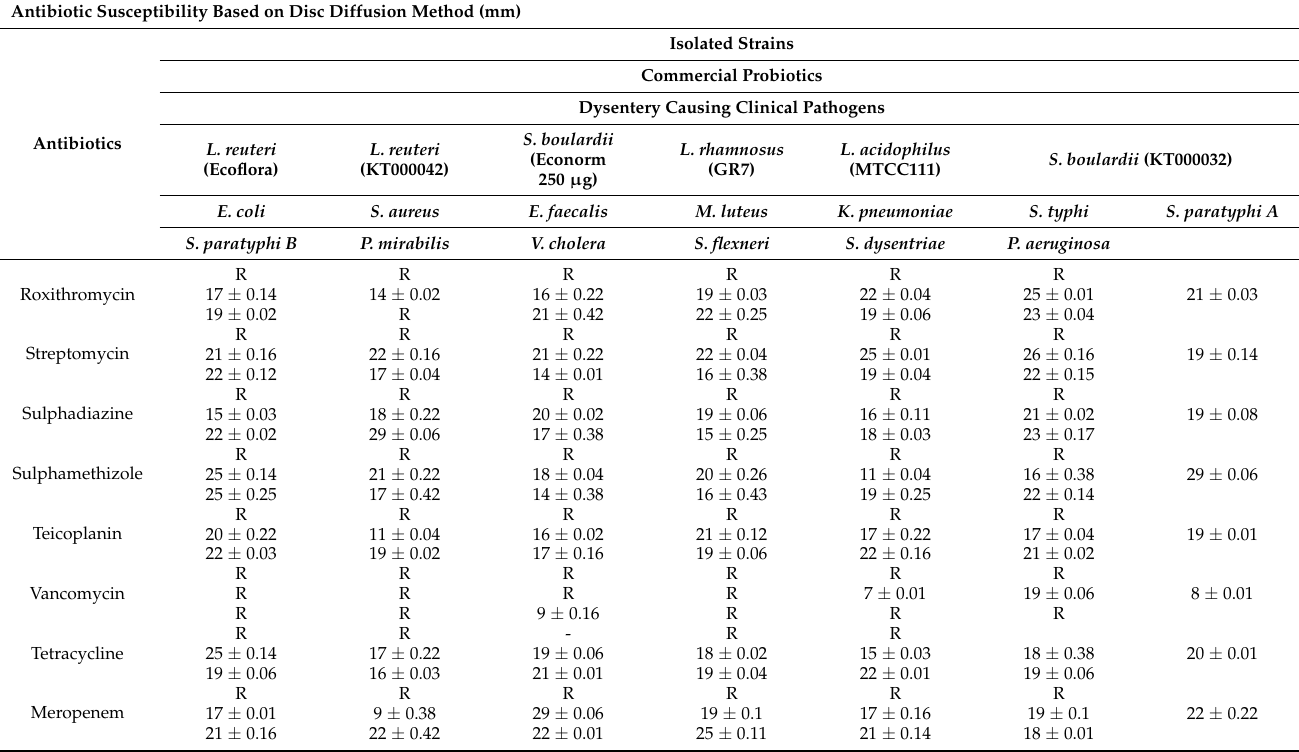
Table 10. Heat stability of S. boulardii strains towards heat treatment at 95 °C and 121 °C with different periods .